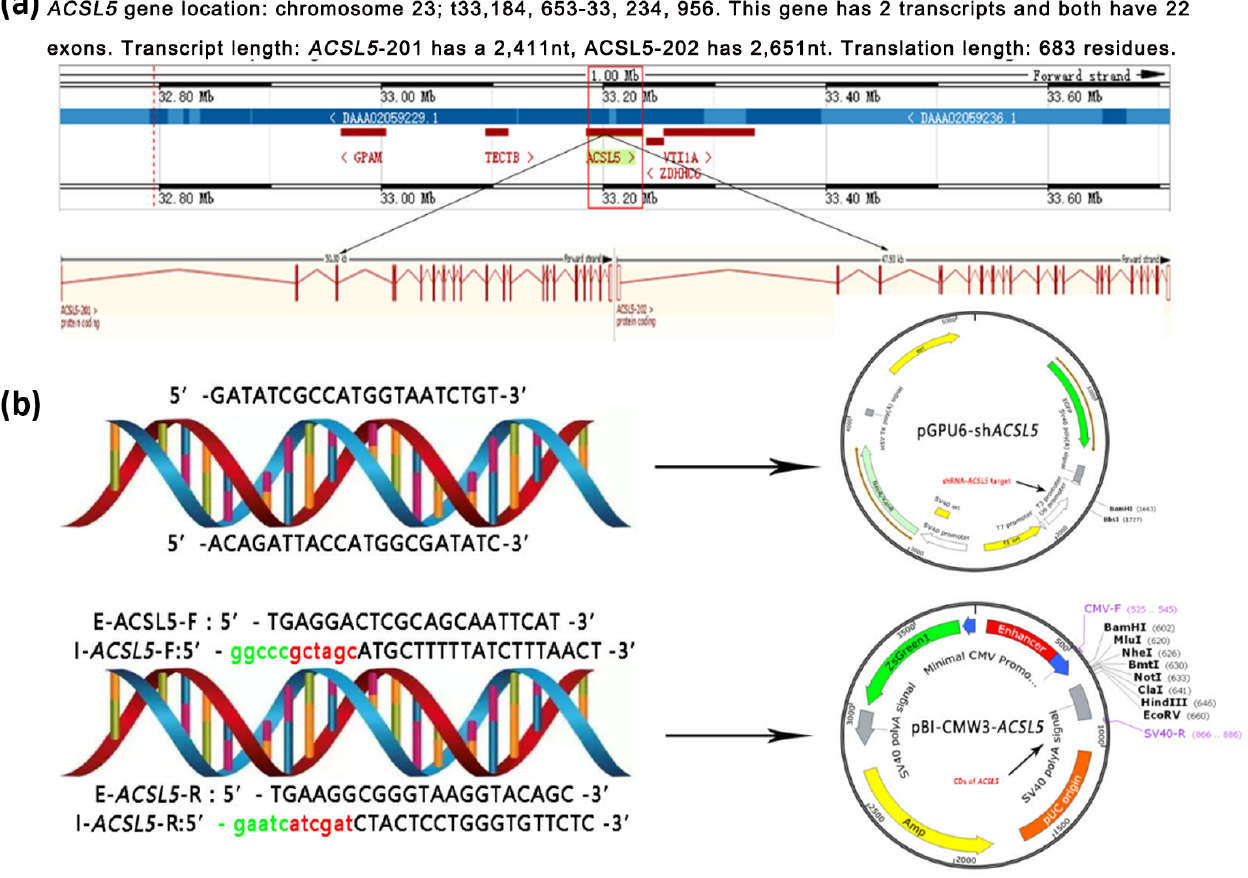
Figure 2. Gene mapping of bovine ACSL5 and vectors incorporating the ACSL5 gene. (a) Bovine ACSL5 gene location and structure features. (b) pGPU6/GFP/Neo-ACSL and pBI-CMV3- ACSL5 . E- ACSL5 : external primers for nested PCR; I- ACSL5 : internal primers for nested PCR (green indicates protective bases, red indicates restriction